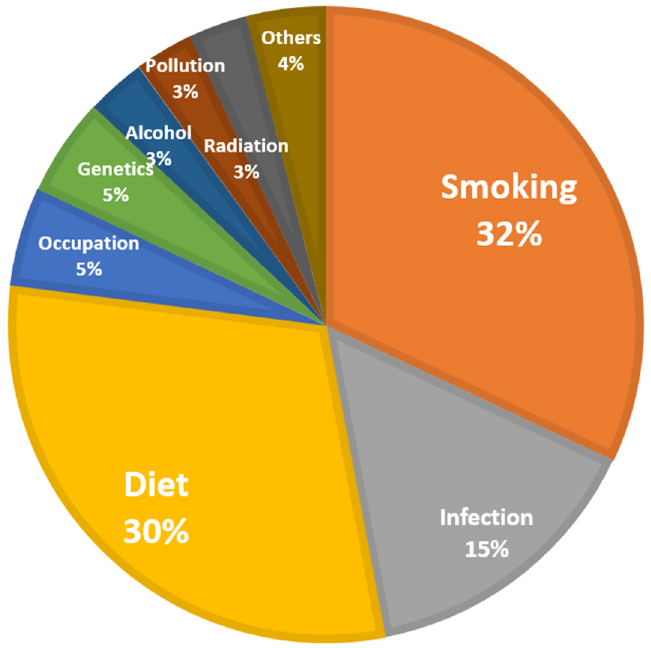
Figure 1. Summary of causes of cancer. Data source: World Cancer Report by IARC, 2008 [13]. Pie chart drawn by authors.